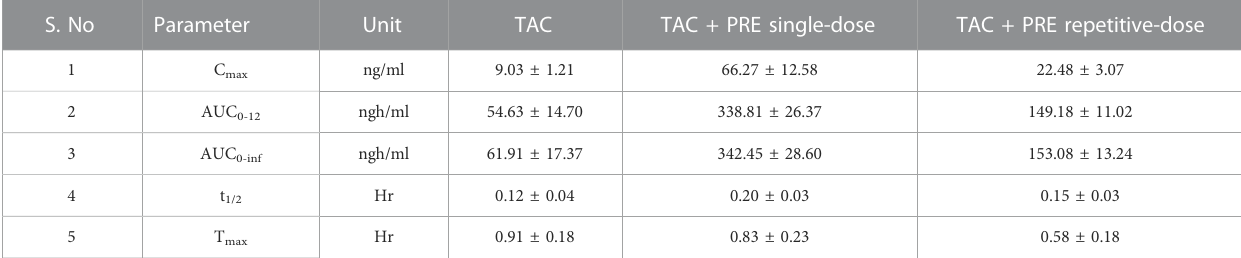
TABLE 2 Pharmacokinetic parameters of tacrolimus in the presence and absence of PRE in a repetitive-dose study. (Cmax, observed maximum plasma concentration; Tmax, time to reach Cmax; AUC, area under concentration – time curve; MRT, mean residence time; Vz, the volume of distribution during terminal phase; and Cl,